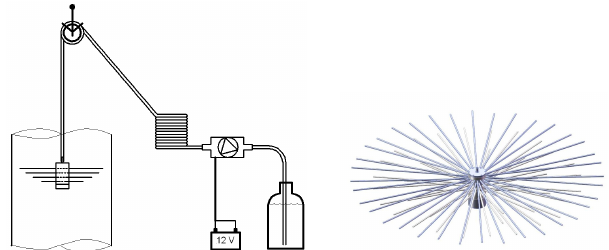
Fig. 7. Left: sketch of setup used for CO 2 manipulation. CO 2 - enriched water is pumped from 25L carboys via a garden hose into the “spider”, which is gradually moved up and down over the en- tire length of the enclosure bag by manually heaving and hauling it via a pulley fixed above the centre of the enclosure bags underneath the hood. Right: the dispersion device (“spider”) is composed of a polyoxymethylen body weighted with a 5kg stainless steel stand. It has 84 jets (Ø500µm) of which 78 are equipped with elastic acryl branches of different lengths distributing the liquid evenly over a horizontal cross-section of the mesocosm. The diameter of the jets serves as a bottleneck, releasing ∼ 80mLmin − 1 of liquid dispensed through every jet irrespective of the length of the branch connected to